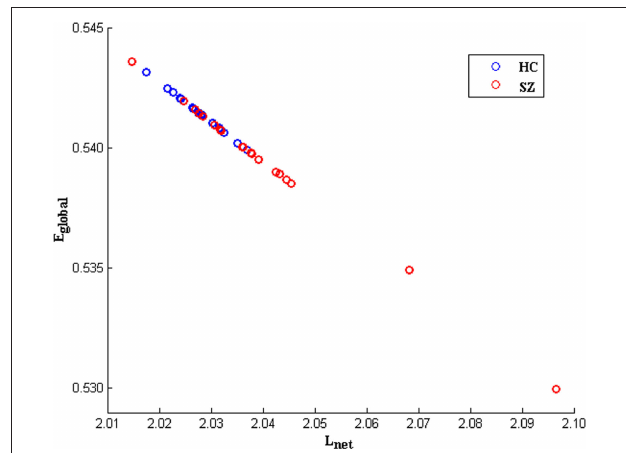
Figure 4 | An example scatter plot of original distributions of global efficiency ( E ) and shortest path length ( L global (blue circles) and SZ (red circles) at degree point K = 13.0 (in the left task-related network). The inverse relationship evident between E L is consistent with the fact the two variables are inversely correlated net by definition.